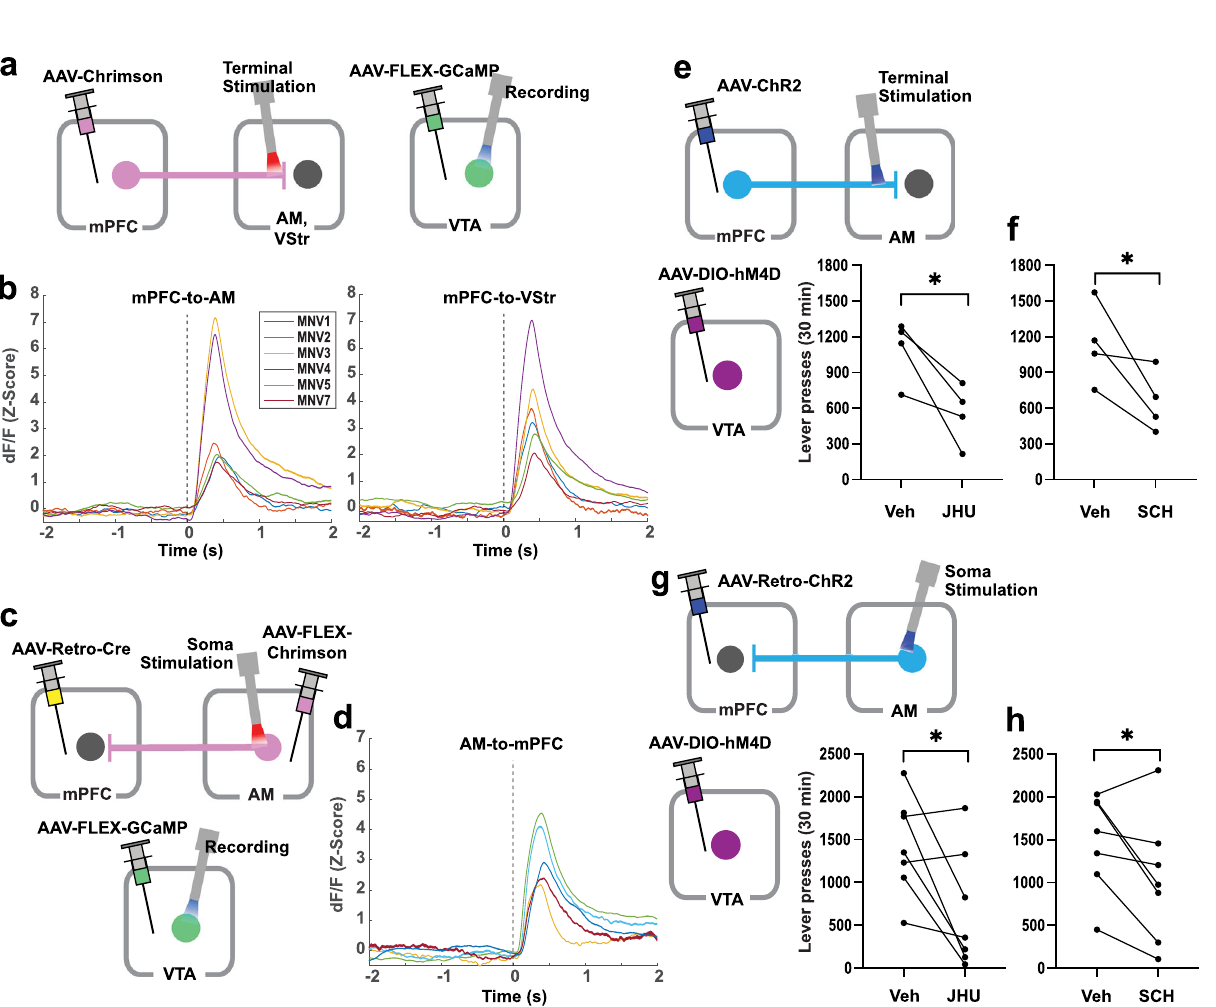
Fig. 6 AM neurons support ICSS and form a positive-feedback loop with mPFC neurons. a – c Left: diagrams showing the sites of the AAV-ChR2-EYFP injections and optic- fi ber implantations. Middle: ICSS data: Responding on the active lever was rewarded with photostimulation (a 25-Hz 8-pulse train) in sessions 3 – 7 and 10 – 11, while no photostimulation in sessions 1 – 2 or 8 – 9. Each line shows lever-press data from a single mouse. Right: photomicrograms showing example EYFP expressions and optic- fi ber tracks. AM projections were found throughout the mPFC with sparse expression. Stronger anterograde expression was tended to be found in the PrL than the IL and the anterior PrL than posterior PrL, and the two highest responders had their placements in the anterior PrL ( b ). Scale bar = 250 µ m. d , e Left: diagrams showing slice electrophysiology preparations with injection sites and stimulation sites. Emx1- Cre and wild-type C57Bl6 mice ( n = 7) were used for the experiments described in ( d ) and ( e ), respectively. Right: stimulation-evoked EPSC. * P = 0.0017 ( t 3 = 10.83) and ** P = 0.0010 ( t 7 = 5.38), ratio paired, two-tailed t -test. f Example traces: On the left, an AM neuron showing a light-evoked response when adjacent PFC terminals are activated. The response is diminished with the application of glutamatergic antagonists. On the right, a PFC neuron showing a light-evoked response when adjacent AM terminals are activated. The response is diminished with application of glutamatergic antagonists. g Mean (±SEM) and individual latencies to response onset as de fi ned as time to achieve 10% of the peak response. * P = 0.0007 ( t 15 = 4.22; n = 9 AM cells; n = 8 mPFC cells), unpaired, two-tailed t -test.